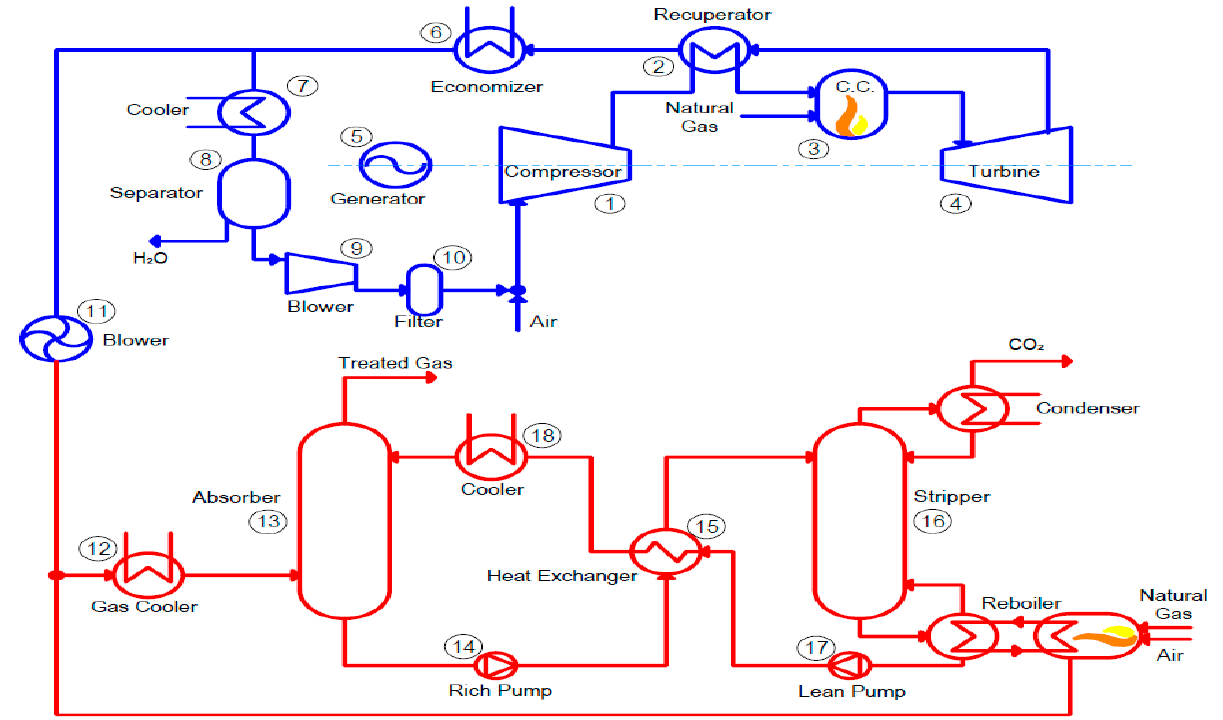
Figure 3. Schematic of the mGT and coupled CC unit representing the mGT Turbec T100 (adapted from [67]).